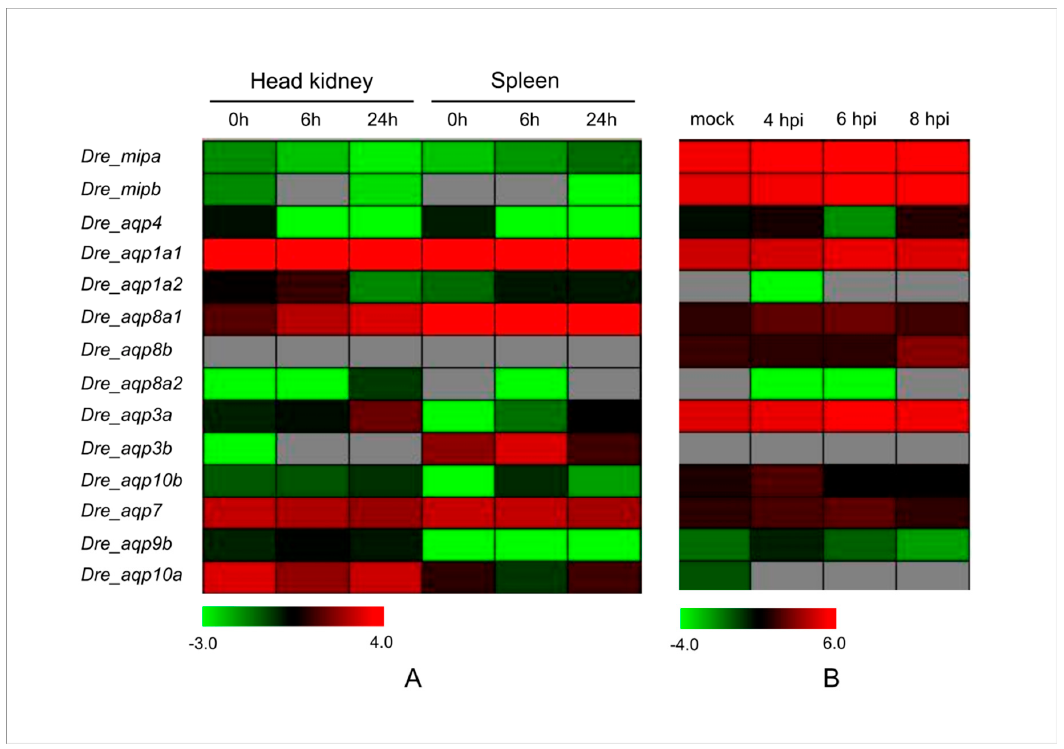
Figure 5. Expression profiles of the zebrafish Aqp genes under some biotic stresses. ( A ) Digit expression profiling of the zebrafish Aqp genes in the spring viremia of carp virus (SVCV)-infected tissues by microarray analysis (GSE63133). ( B ) Dynamic expression profiles of the zebrafish Aqp genes under the Mycobacterium marinum infection from GSE76499. Embryos at 4, 6, and 8 h post injection (hpi) and the uninfected mock were collected for RNA-seq analysis.